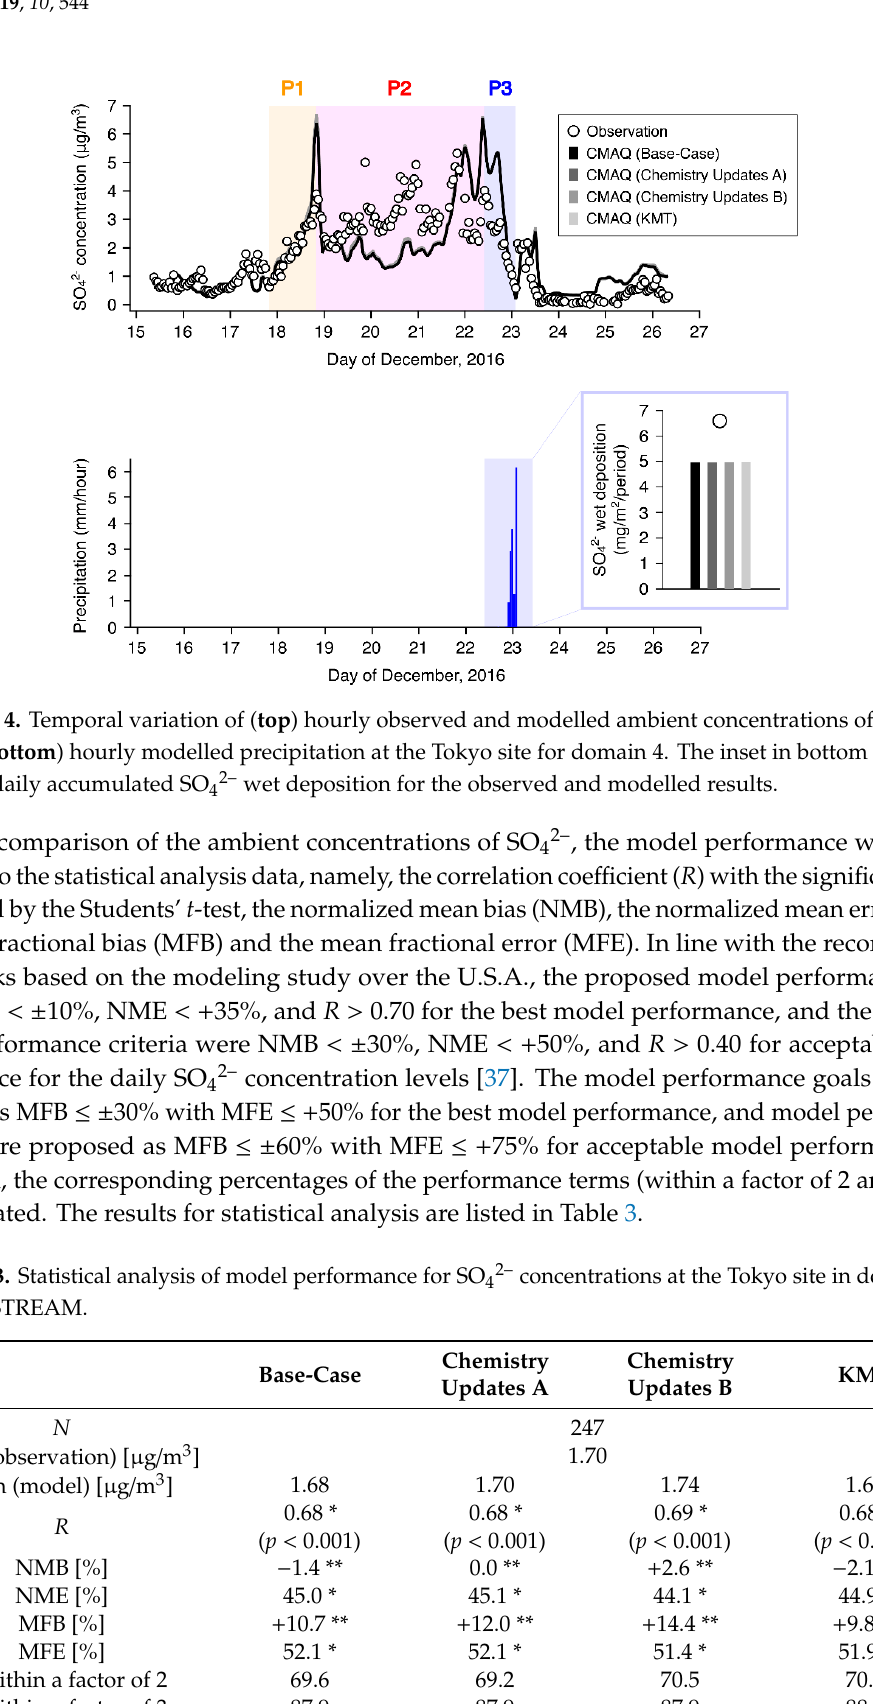
Table 3. Statistical analysis of model performance for SO 42– concentrations at the Tokyo site in domain 4 of J-STREAM.